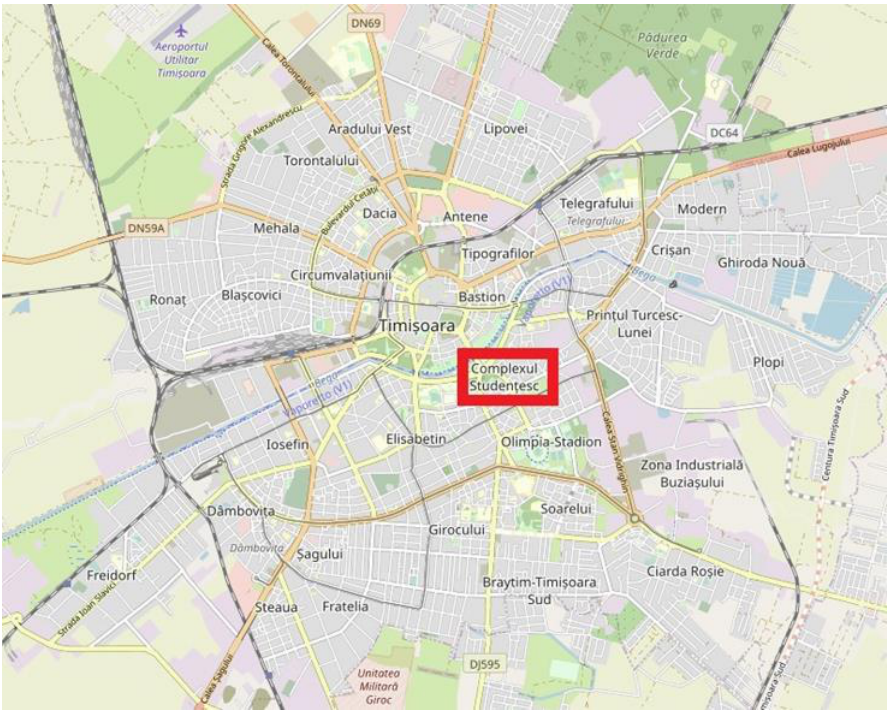
Figure 1. Map of Timisoara, with the student campus highlighted in the box.